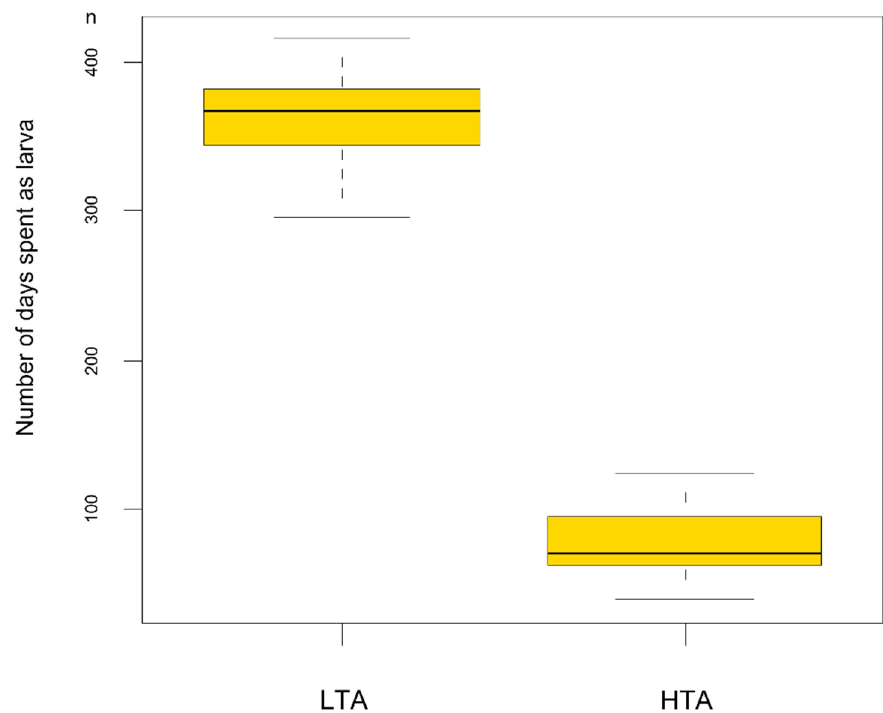
Figure 2. Boxplot showing the relationship between larval stage duration and the food treatment experienced. LTA = low trophic resources availability; HTA = high trophic resources availability.